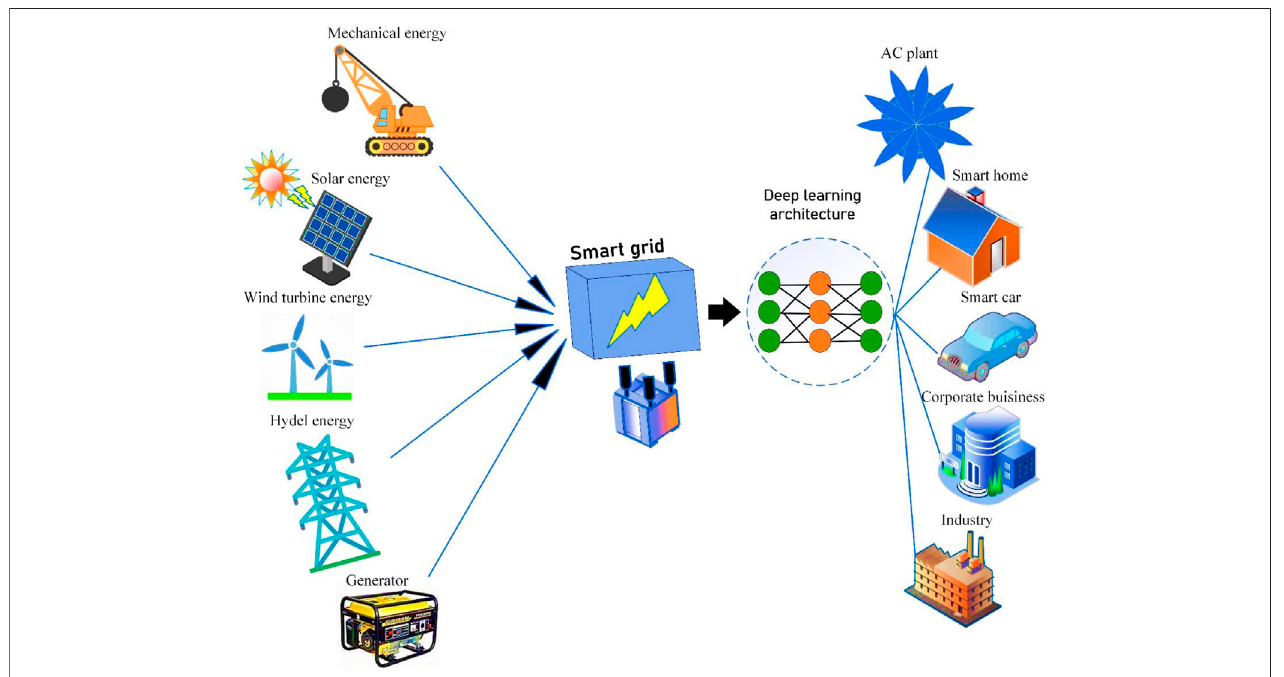
FIGURE 2 | Proposed conceptual